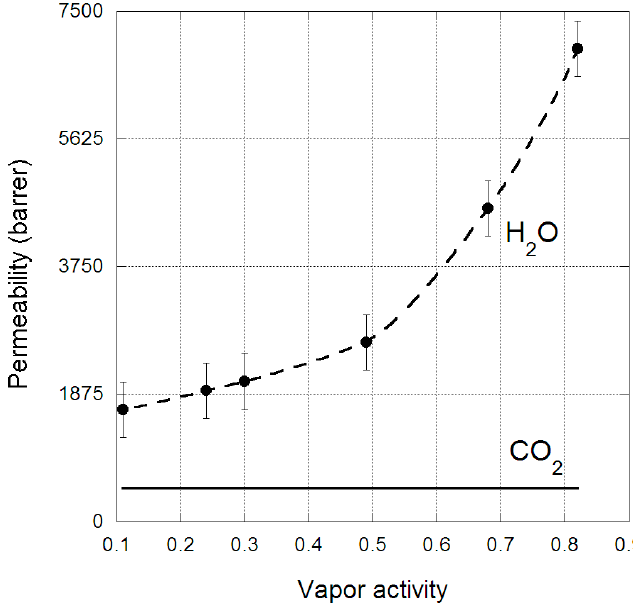
Figure 3. Permeability (barrer) of water and CO 2 through composite 6FDA-TMPDA membranes under mixed gas conditions for a total thickness at 50 µm at 35 °C, for different water activities.